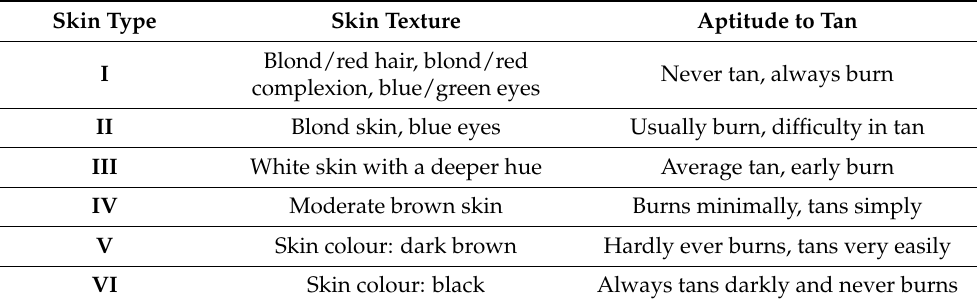
Table 1. Fitzpatrick skin phototype classification system on the basis of skin texture and propensity to tan or